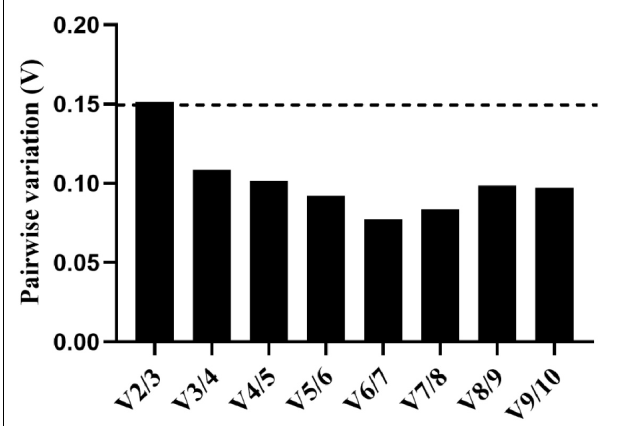
FIGURE 3 | Pairwise variation (V) of 10 reference genes calculated by geNorm. The threshold value for assessing the optimal number of reference genes for Real-time quantitative polymerase chain reaction (RT-qPCR) normalization is